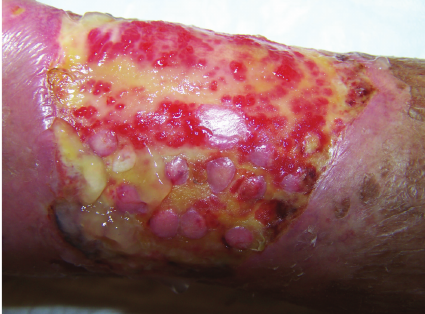
Figure 4: Epithelialization of the edge and epithelial islands inside theulcer,onemonthlatersurgerytreatmentwithpunchgraftingand platelet-rich plasma.